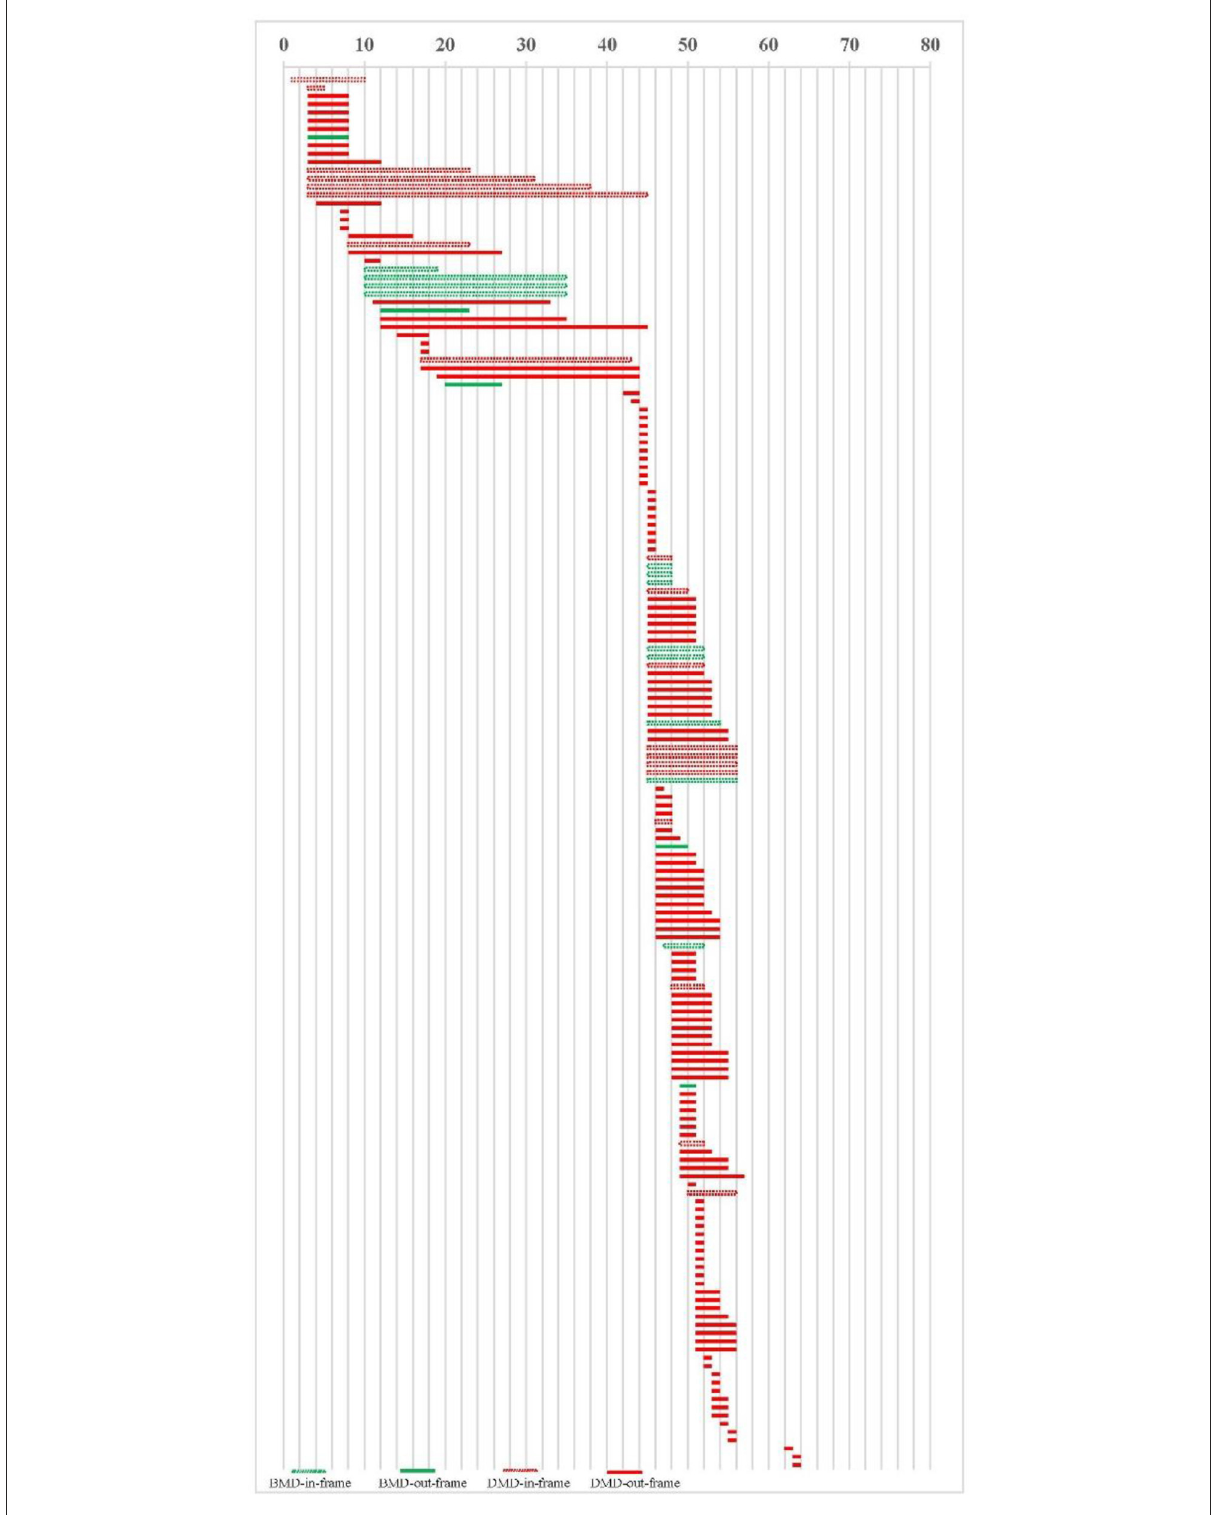
FIGURE2 Deletion and duplication location in 169